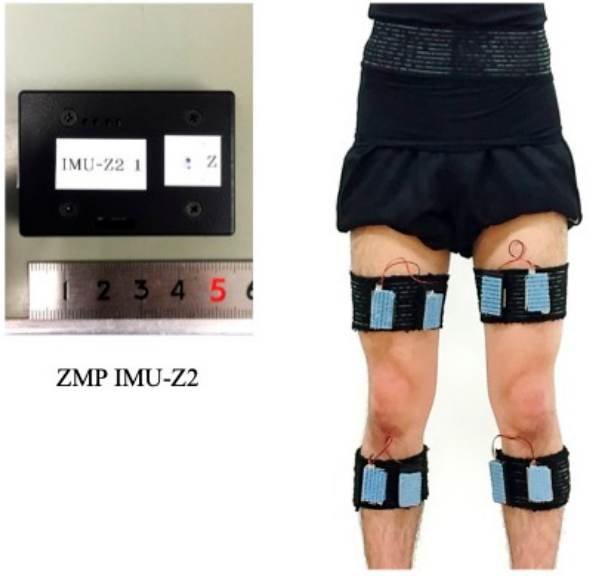
Figure 1. Measurement set-up.